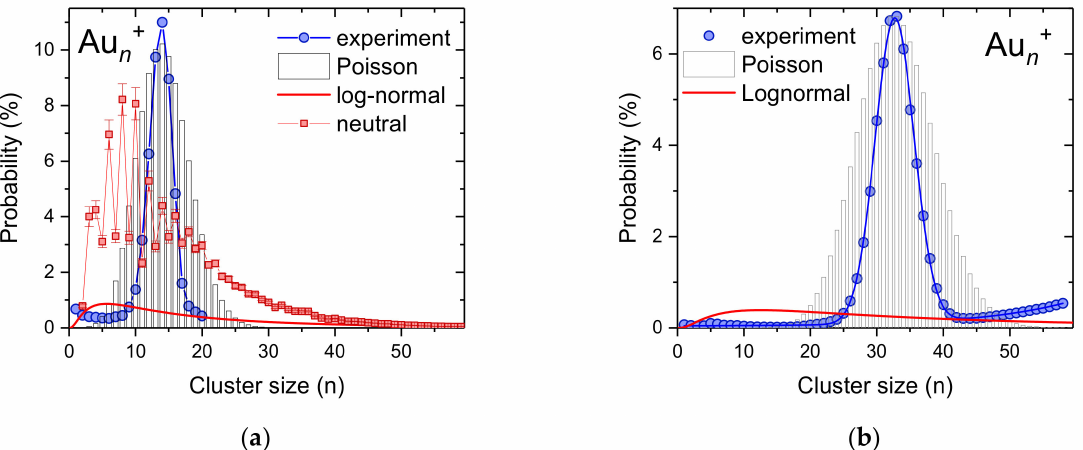
Figure 3. Measured size distribution of gold cluster ions obtained via pickup of gold atoms into highly-charged helium droplets (blue circles, 6 × 10 4 He atoms per charge). At an oven power of 140 W the average size of the Au n + clusters is 13 ( a ) and for 190 W the gold clusters contain an average of 33 gold atoms ( b ). The bar graph are Poisson distributions with expectation values corresponding to the average cluster sizes and the red lines are log-normal distributions. The red squares in ( a ) represent a Au n + cluster size distribution obtained via electron ionization of neutral He droplets doped with gold. The average cluster size of this distributions is also